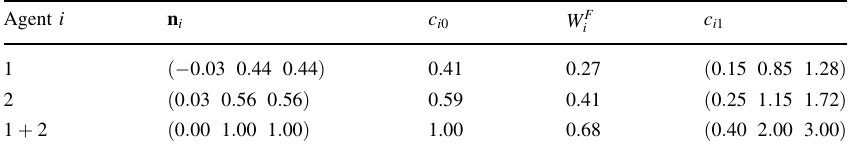
Table 3 Summary of agents’ portfolios, consumption and wealth in the no-tax economy